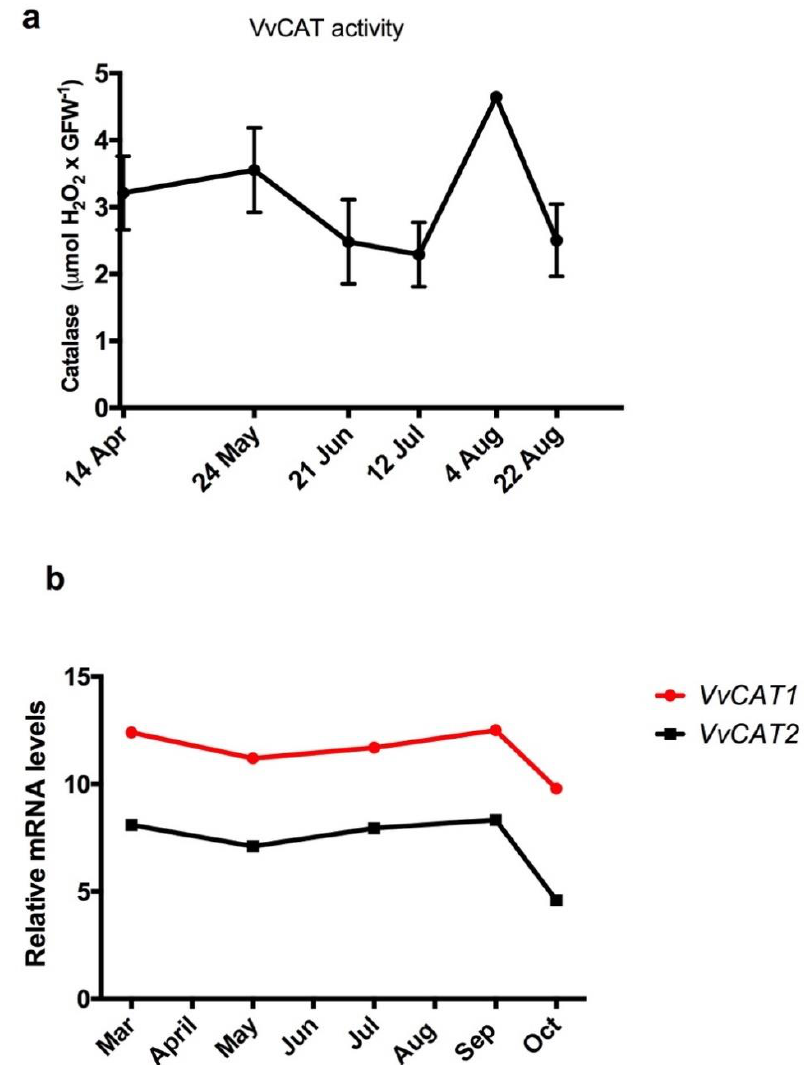
Figure 4. Catalase activity and expression of catalase genes in grapevine buds during endodormancy. ( a ) Catalase activity during endodormancy in Thompson seedless grapevine buds grown in Santiago, Chile. ( b ) Expression of catalase genes ( VvCAT1 and VvCAT2 ) in buds of Tempranillo grapevines grown in Alcalá de Henares, Madrid [21] and adapted to the Southern Hemisphere conditions.